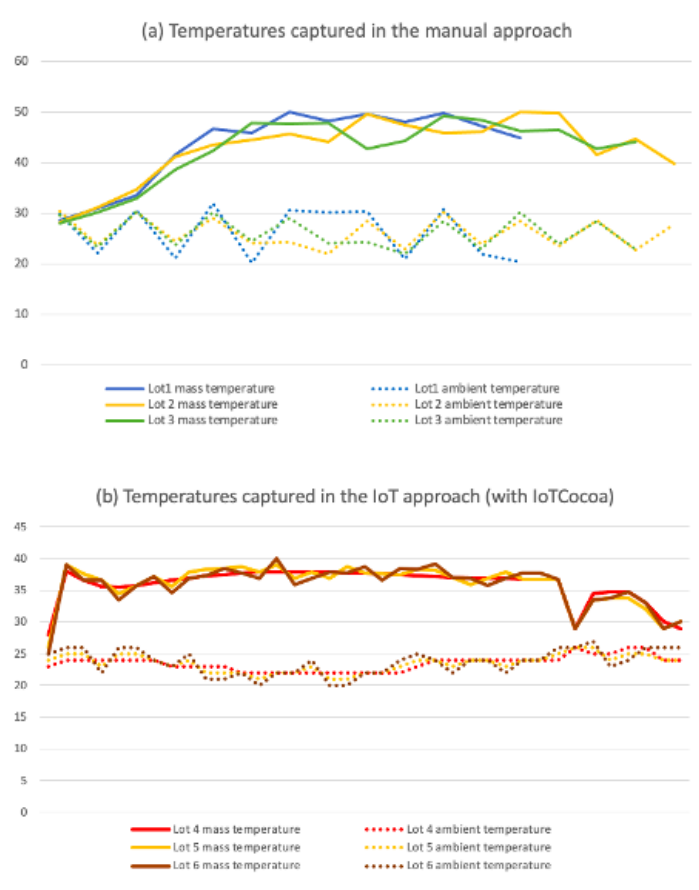
Figure 9. Cocoa mass and ambient temperature variation captured from ( a ) manual and ( b ) auto- mated